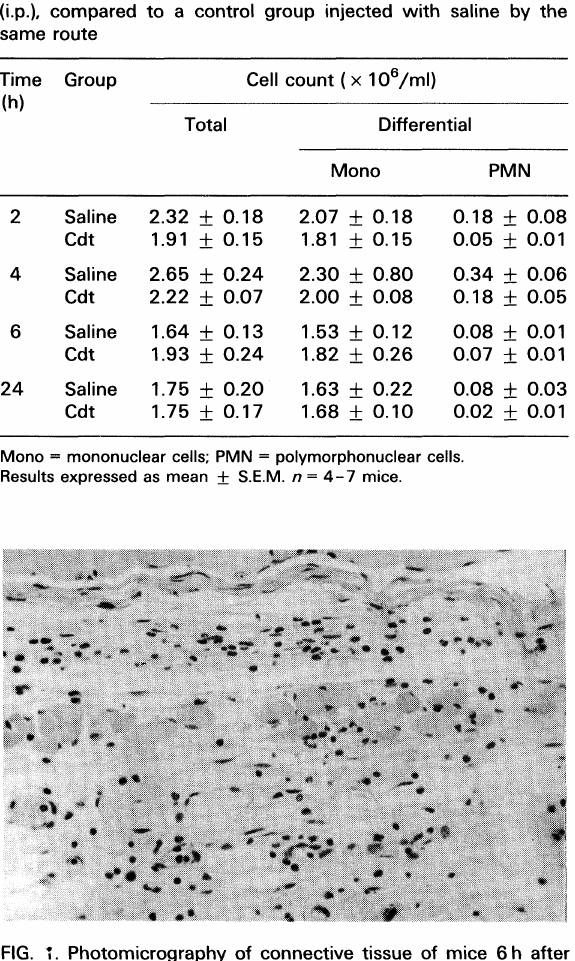
FIG. I. Photomicrography of connective tissue of mice 6 h after the injection of 1.5 lg C.d.terrificus venom, showing a mild infil- trate of inflammatory cells. H.E. (450 x ).